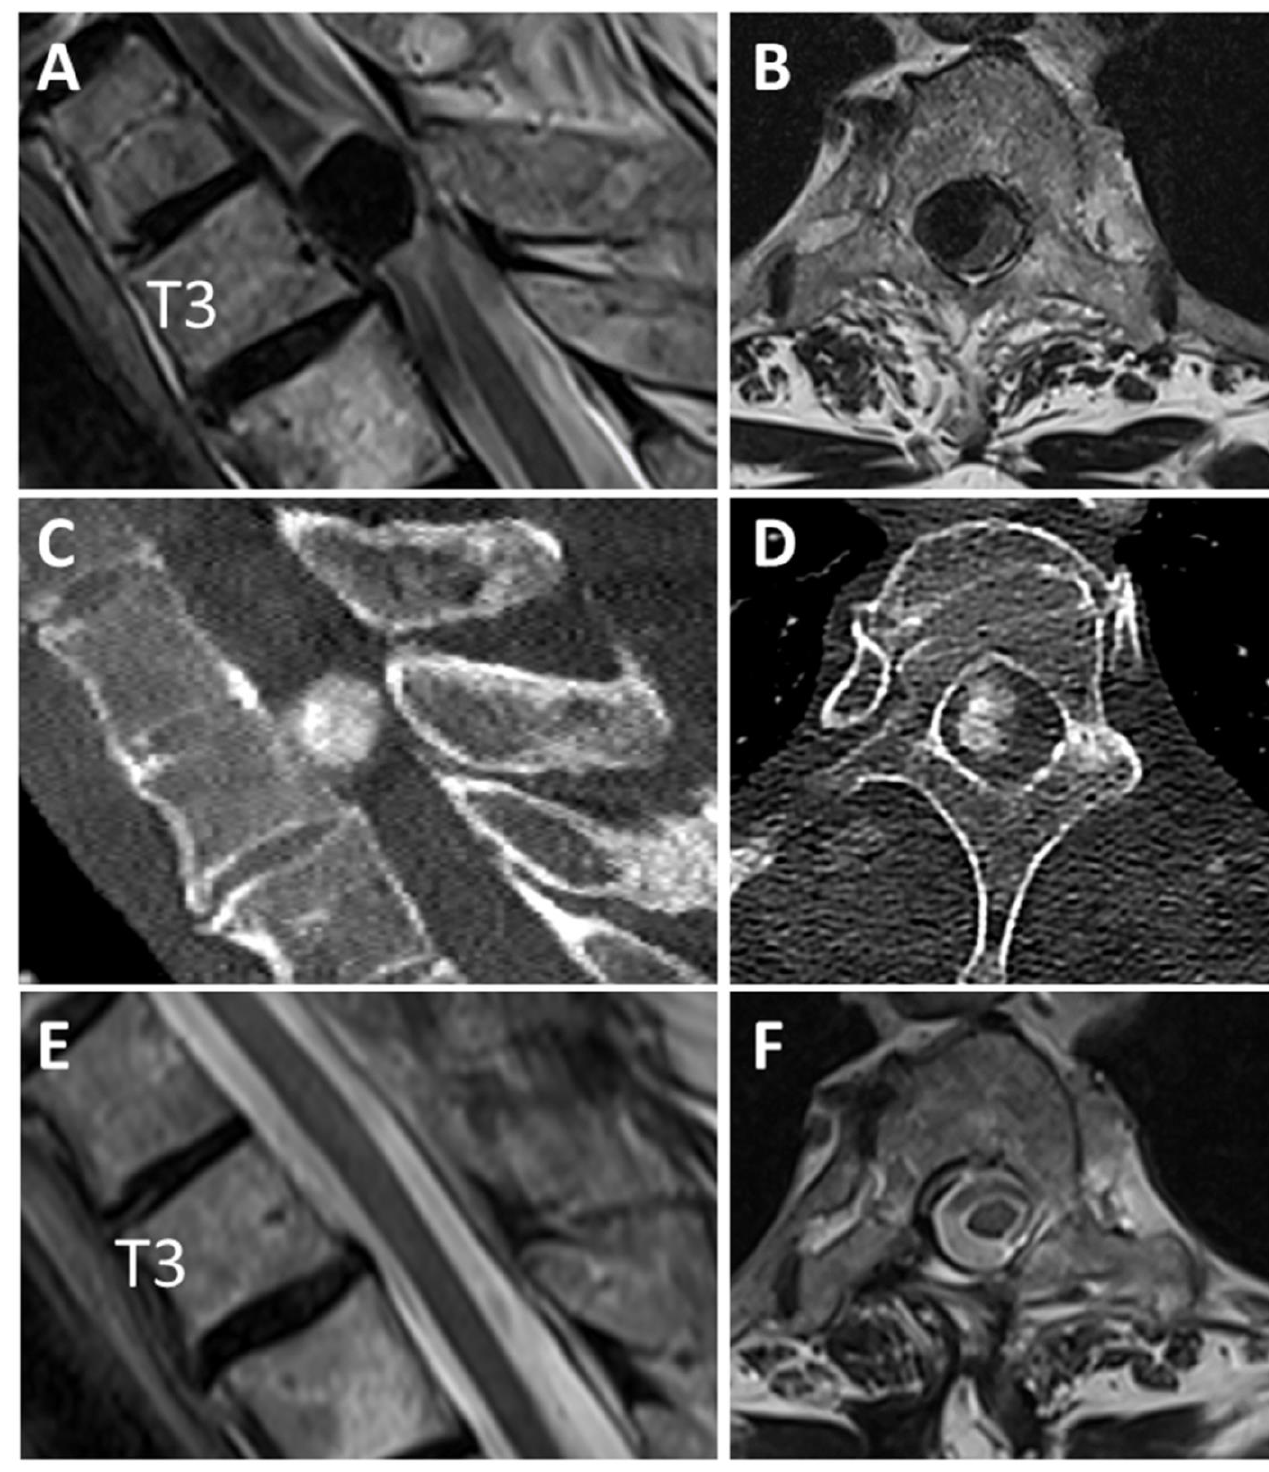
Figure 3. Ossified spinal meningioma at T3 of a 78-year-old woman presenting with gait disturbance and sensorimotor deficits (BMR 4/5). ( A , B ) Preoperative sagittal and axial T2-weighted MR images show a large intradural extramedullary lesion at T3 with displacement and compression of the spinal cord. Tumor-canal ratio (TCR) was 61%. ( C , D ) The CT scans revealed an ossification of the lesion. ( E , F ) Post-operative sagittal and axial T2-weighted MR images show complete resection with no signs of recurrent meningioma 1 year after surgery.